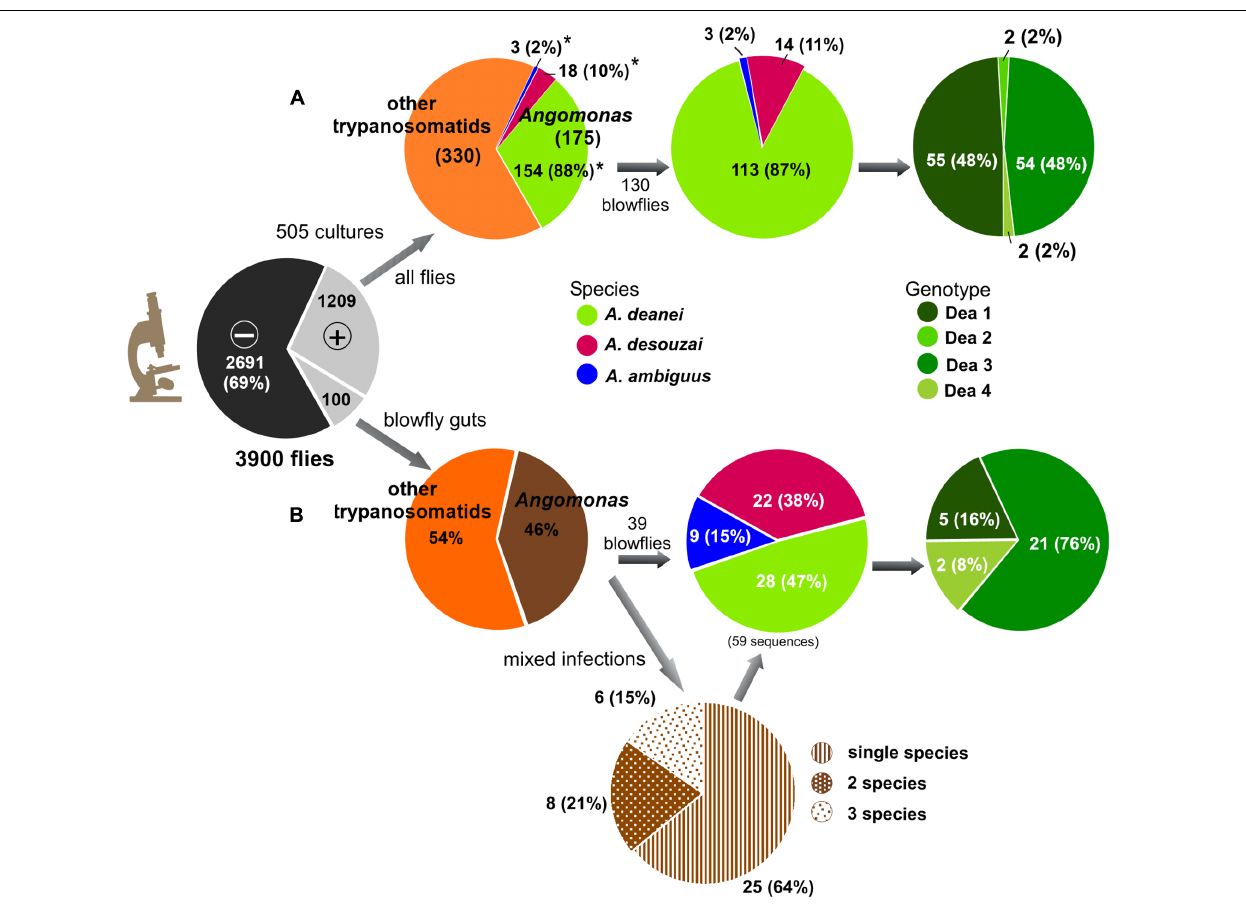
FIGURE 2 | Genetic diversity of Angomonas in flies collected in Africa and Latin America. Surveys of trypanosomatids carried out by culturing on 3,900 flies followed by molecular analyses unveiled A. deanei , A. desouzai , and A. ambiguus, and four genotypes (Dea1–Dea4) of A. deanei in: (A) 505 cultures obtained from 1,209 fly guts microscopically positive (+) for trypanosomatids: 175 cultures were identified as Angomonas spp. by V7V8 SSU rRNA barcoding, and 130 cultures were further characterized using GAPDH sequences; (B) 100 blowfly microscopically positive guts surveyed by PCR-screening based on symbiont-GAPDH sequences. Sou, A. desouzai ; Amb, A. ambiguus ; Dea1–Dea4, A. deanei